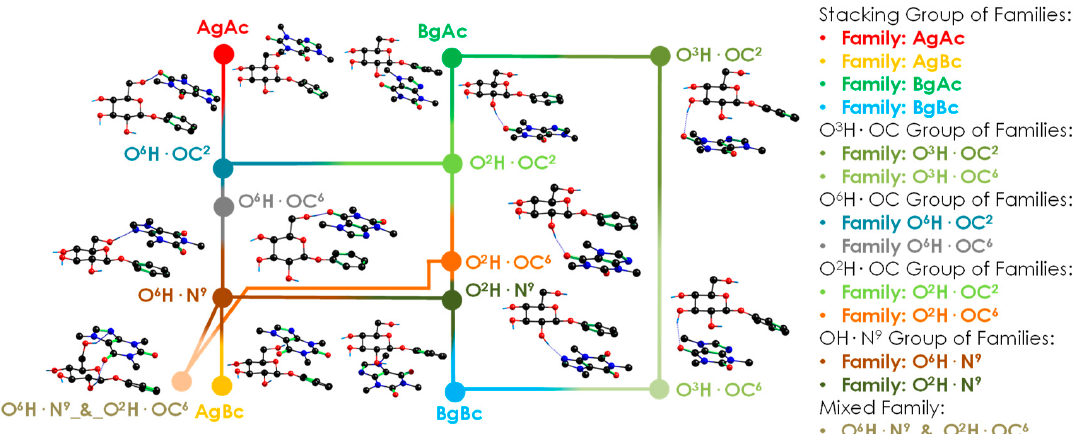
Figure 2. Here a simplified picture of the iPES is shown. There are 13 families or interaction’s types identified. These interactions are classified in groups of families that are related to the similarity in the interaction and the related infrared spectral contribution. The average spectral contributions of each family are available in Table S1, while the contributions of each group of families are presented in Figure S1.